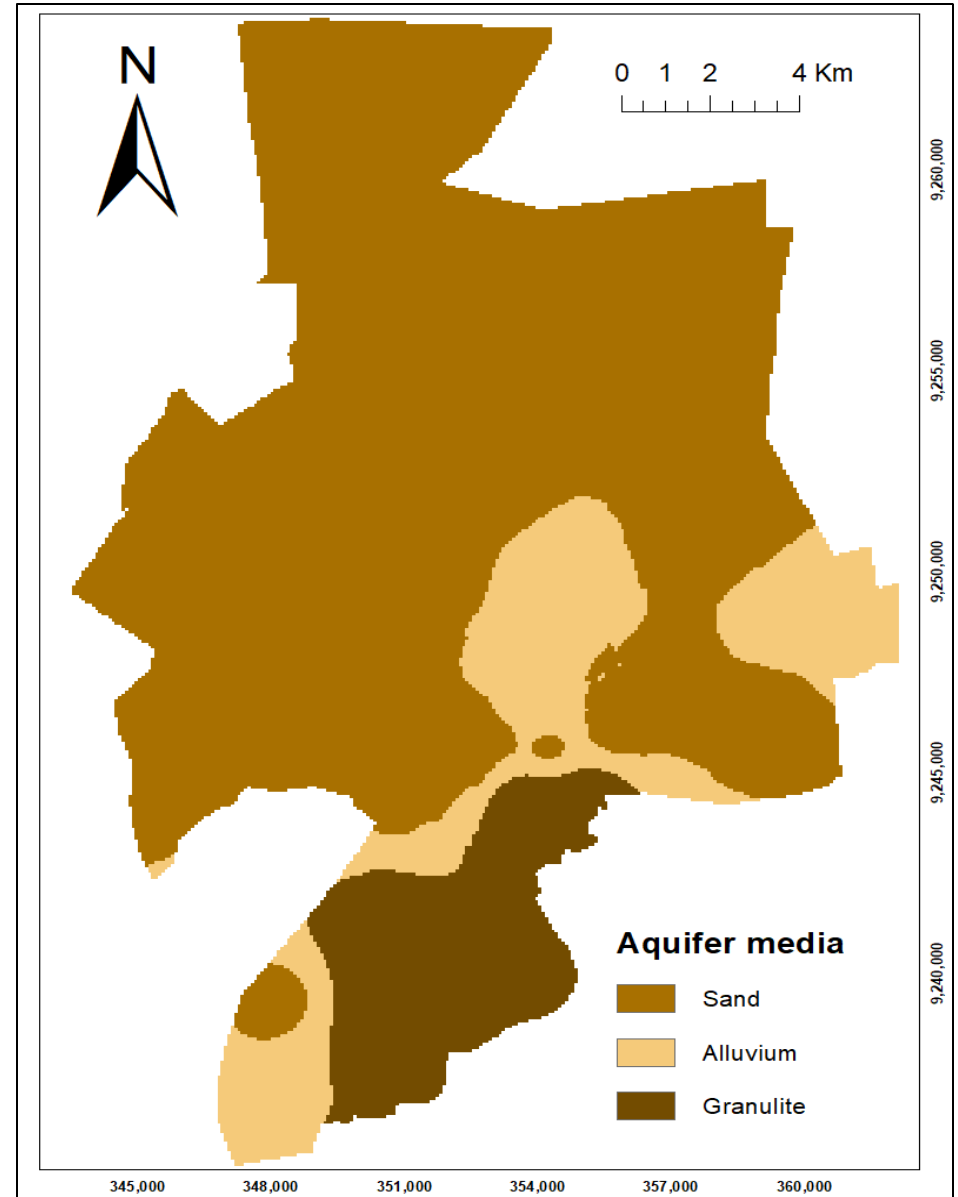
Figure 6. Aquifer media map.